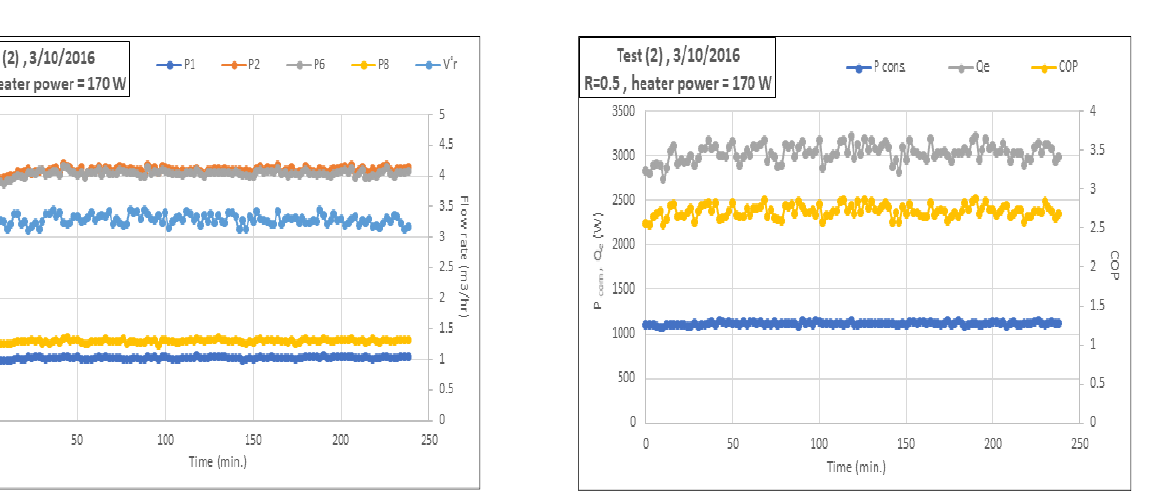
Fig. 12b. Power consumption, cooling capacity and coefficient of performance with time for test 2.